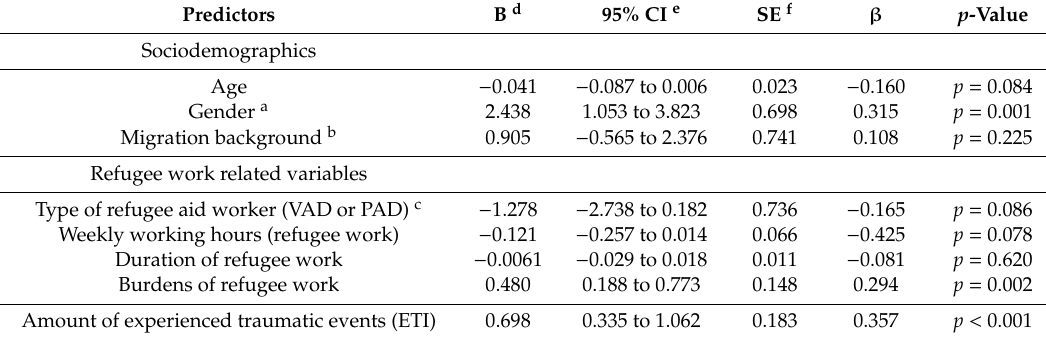
Table 5. Predictors of severity of depressive symptoms in refugee aid workers (PHQ-9 total score; N =